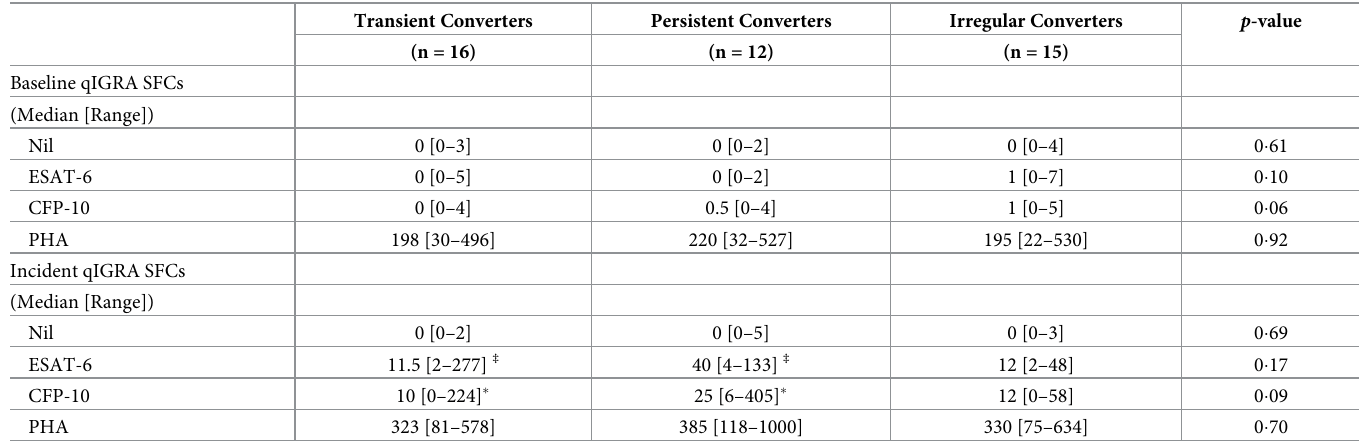
Table 5. IGRA results at baseline and at time of first positive IGRA for subgroups of converters.